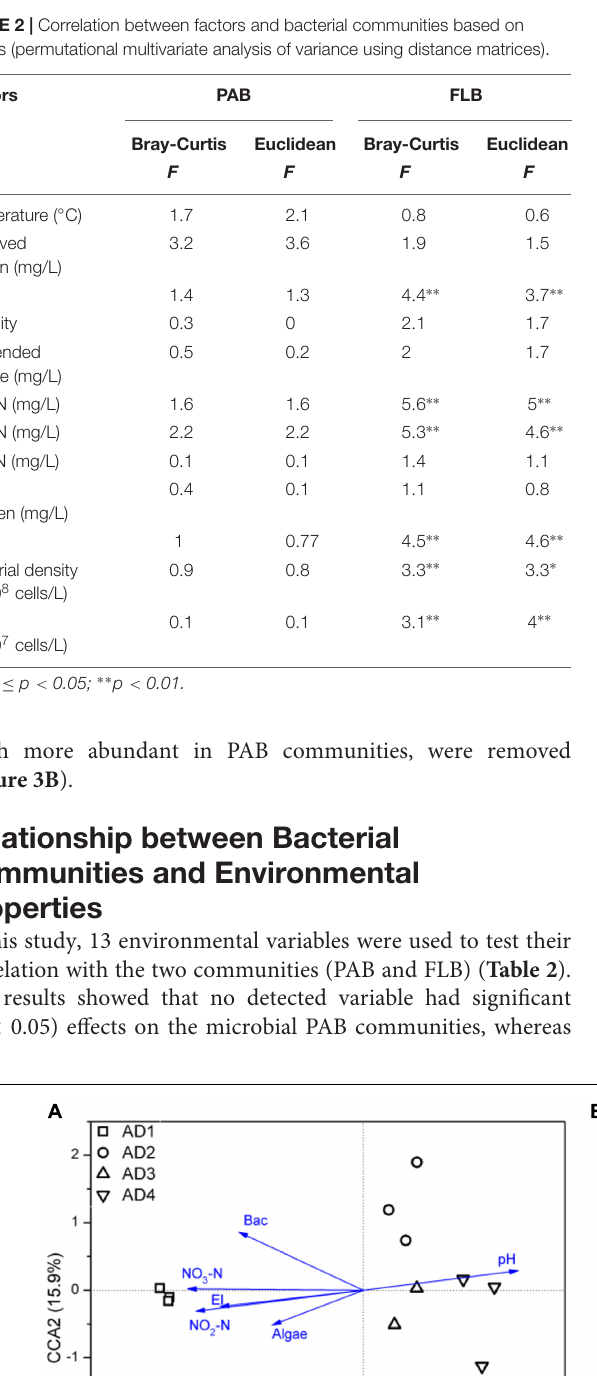
Frontiers in Microbiology |